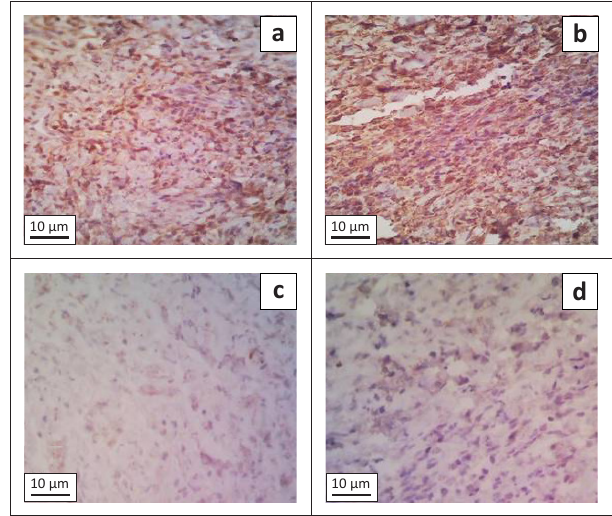
FIGURE 6: Immunohistochemical staining with, (a) S-100, (b) vimentin, (c) desmin and (d) cytokeratin. Positive cells are brown. The neoplastic cells in parts of the neurofibroma express S-100 and vimentin